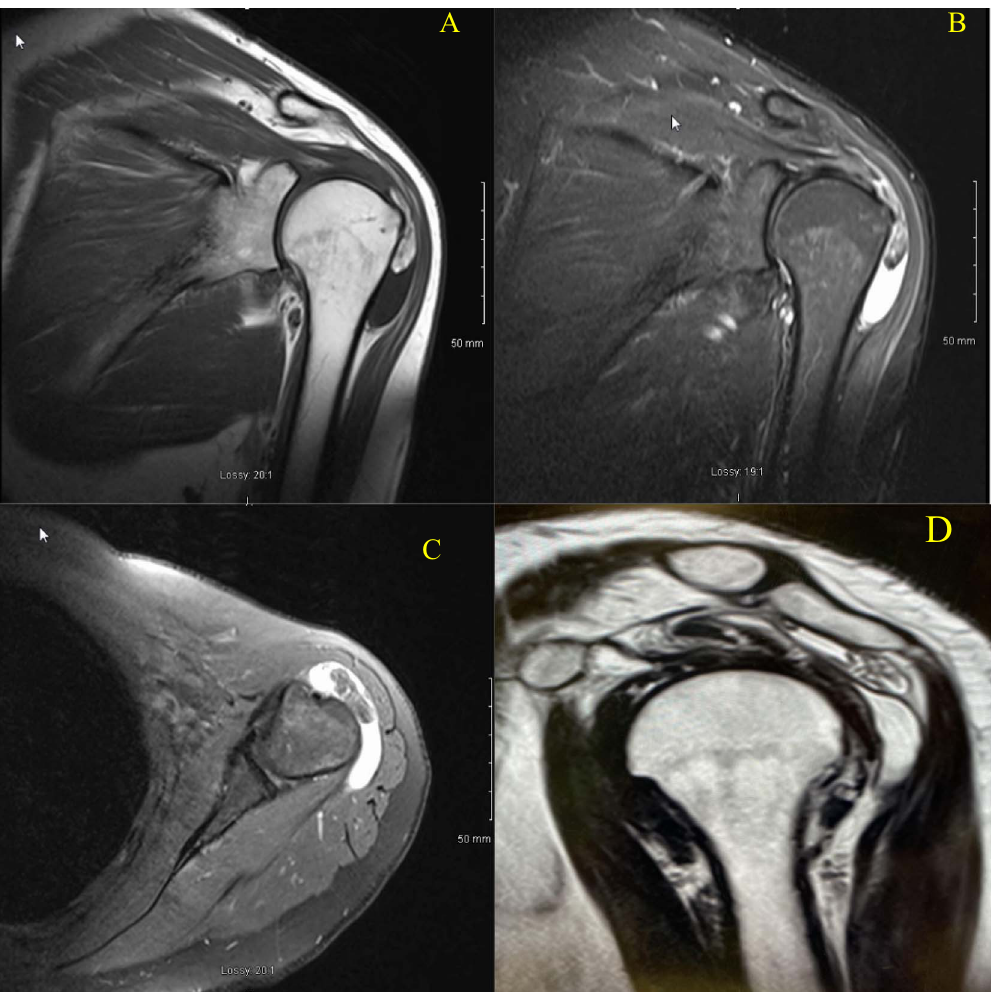
Figure 1. Extra-articular lipoma arborescens. (A) T1 coronal MRI (B) T2 coronal MRI (C) T2 axial MRI and (D) T1 sagittal MRI showing: fat-containing, lobulated synovial mass (2.5 (cid:1) 1.0 (cid:1) 0.5 cm) in the subacromial-subdeltoid bursa with fat signal intensity on all